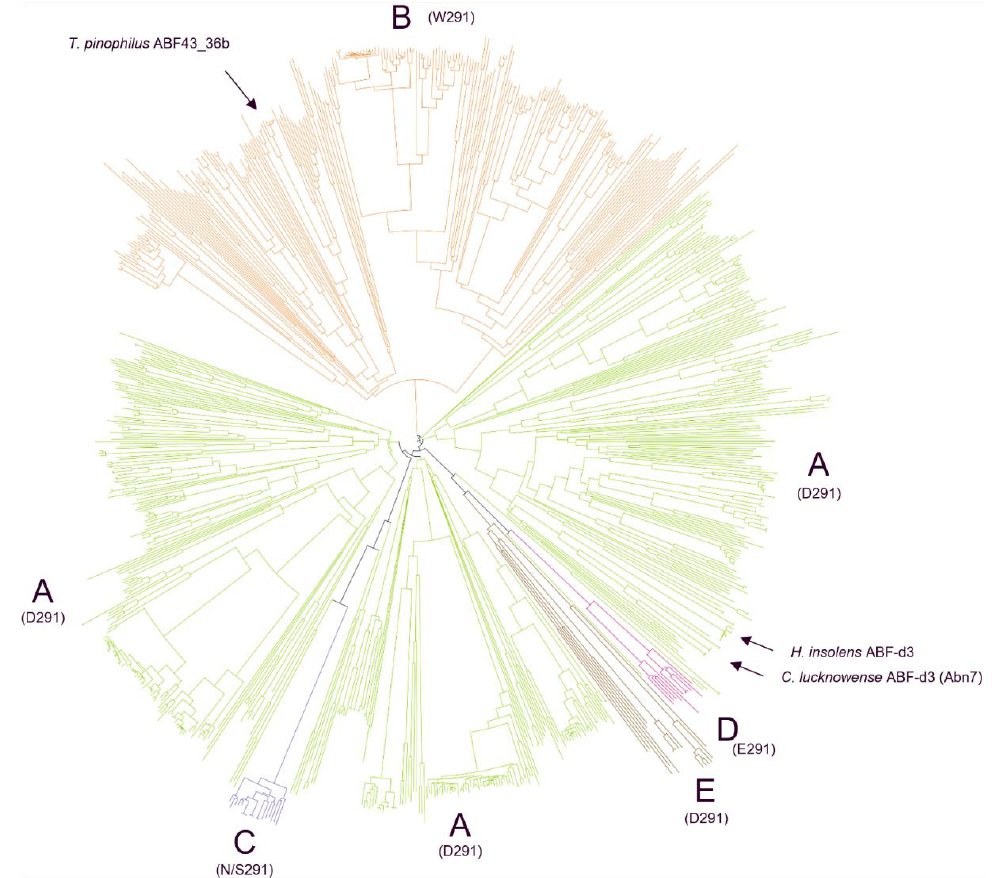
Figure 1. Phylogenetic relations of publicly available GH43_36 sequences of the Ascomycota phylum separated into two main clusters. Cluster 1 contains clades A, C, D, and E, and cluster 2 is defined by clade B. In clade A (green), all candidates have an Asp at position 291, and clade A contains the currently characterized ABF-d3s ( H. insolens and C. lucknowense ). Clade B (orange) candidates have Trp at position 291, and the Tp ABF43_36b used in this study is part of this clade. Clade C (dark purple) candidates have Asn or Ser at position 291, while clade D candidates (pink) have Glu, and clade E (brown) candidates have Asp at position 291.